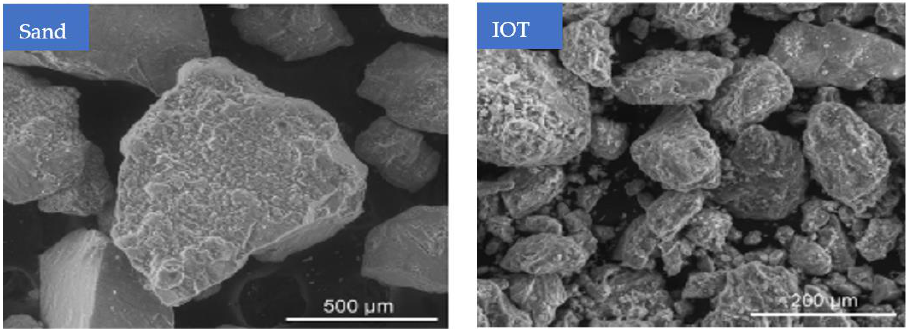
Figure 3. SEM of iron ore particles (used with permission, Elsevier [37]).